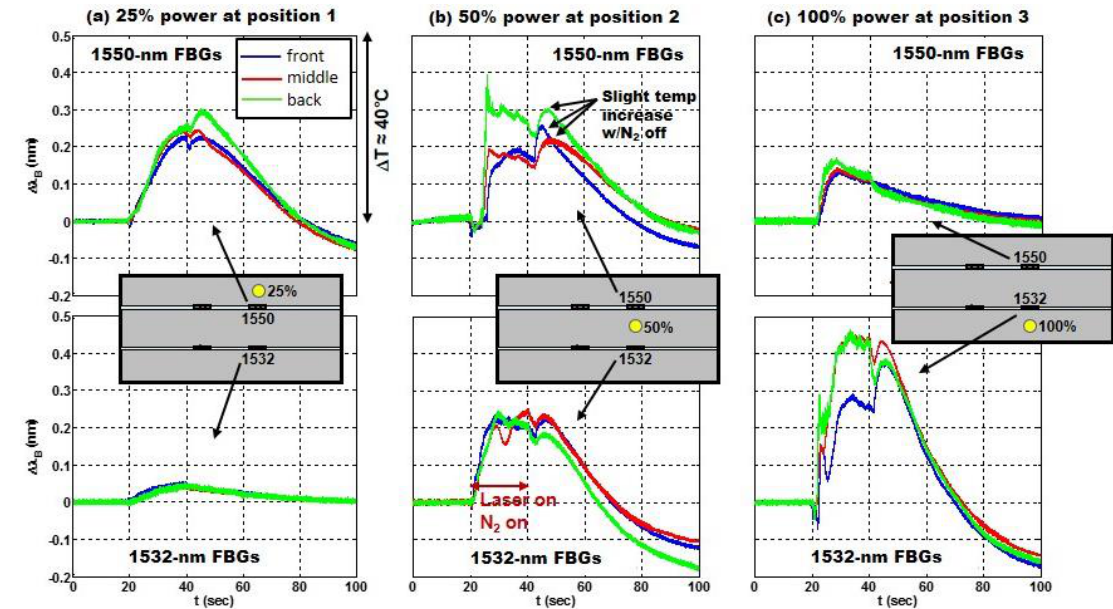
Figure 11. ( a – c ) The shift ∆ λ B vs. time for the FBGs with nominal Bragg wavelengths of 1550 nm and 1532 nm during laser strikes at positions 1–3, respectively, in Figure 10. The laser (and N 2 gas) turned on at 20 s and off at 40 s. The specimen was oriented with air flow from right to left in strikes 1–3. The location of the strike, the relative laser power level and the corresponding FBG are shown in the inset for each pair of graphs.